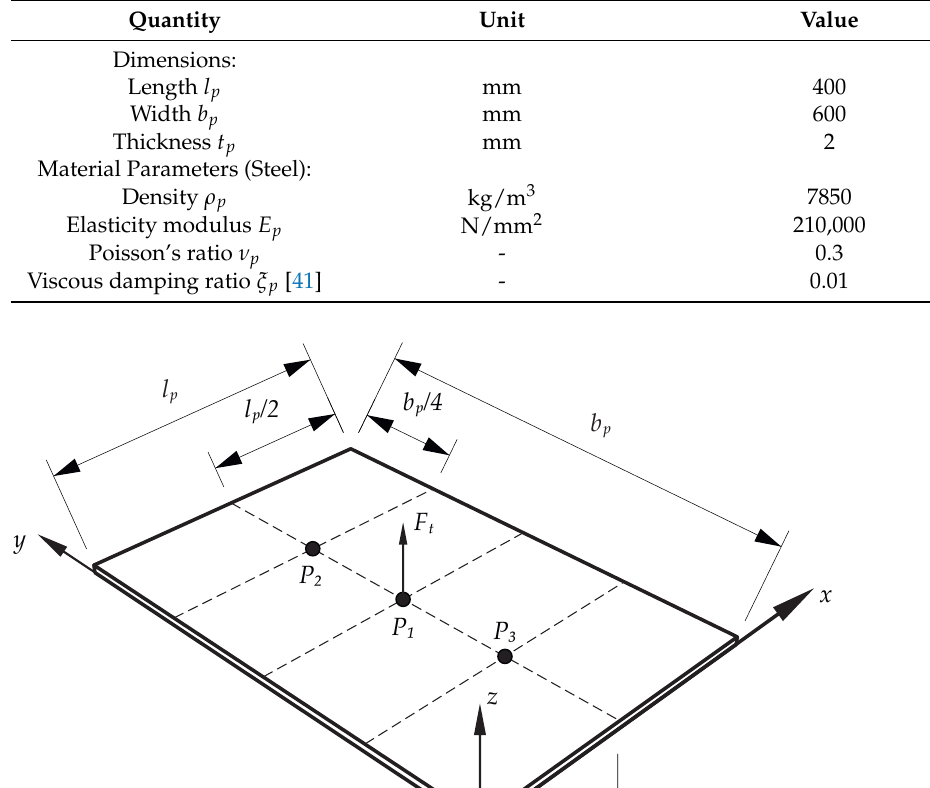
Table 2. Parameters of the plate.